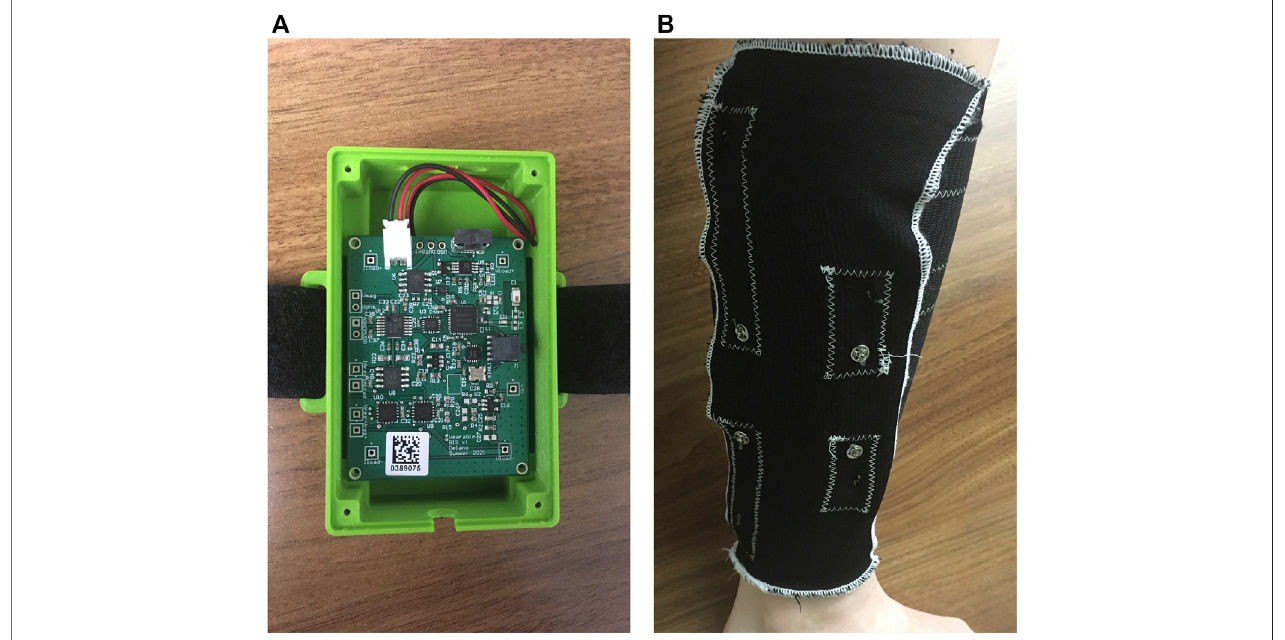
FIGURE 3 | (A) The custom PCB inside the enclosure. Electrode connection and other wires not pictured. (B) The textile compression sock while